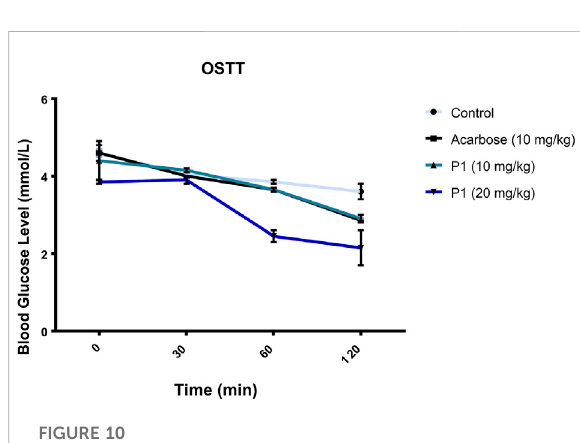
FIGURE 9 Per residue root mean square fl uctuations (RMSF) plots of moleculardynamics(MD)simulationofhumanpancreaticamylase (HPA) and in complex with the isolated steroidal pregnanes.